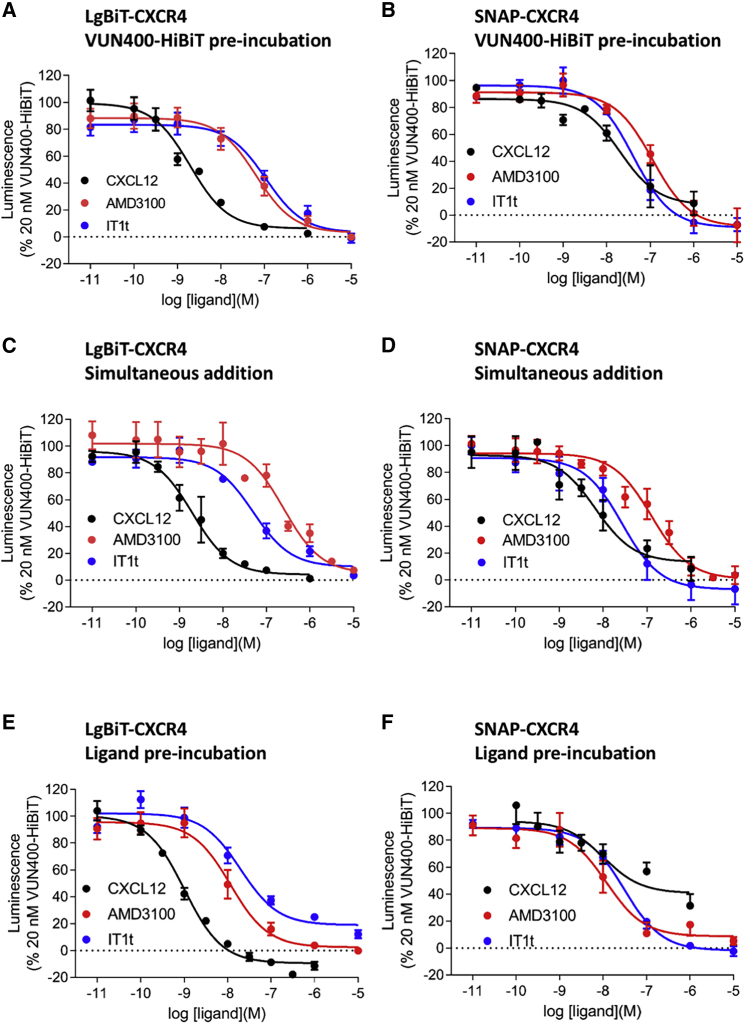
Displacement of VUN400-HiBiT by Competing LigandsHEK293 cells stably expressing LgBiT-CXCR4 (A, C, E) or SNAP-CXCR4 (B, D, F) were treated with 20 nM VUN400-HiBiT and CXCL12, AMD3100, or IT1t. (B, D, F) 20 nM exogenous LgBiT added to complement with bound VUN400-HiBiT following the removal of unbound VUN400-HiBiT with washing. (A and B) Cells treated with 20 nM VUN400-HiBiT for 30 min prior to the addition of CXCL12, AMD3100, or IT1t. (C and D) Cells treated with VUN400-HiBiT and CXCL12, AMD3100 or IT1t simultaneously. (E and F) Cells treated with CXCL12, AMD3100, or IT1t for 2 h prior to the addition of VUN400-HiBiT. For all experiments, 0% luminescence was defined as complemented luminescence obtained with 20 nM VUN400-HiBiT in the presence of 10 μM AMD3100. Data are combined mean ± SEM from at least three separate experiments, where each experiment was performed in triplicate. See Table 1 for full details of number of experimental repeats.